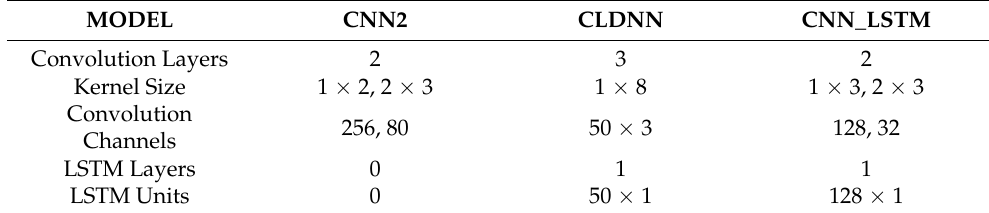
Table 3. Structural parameters of different